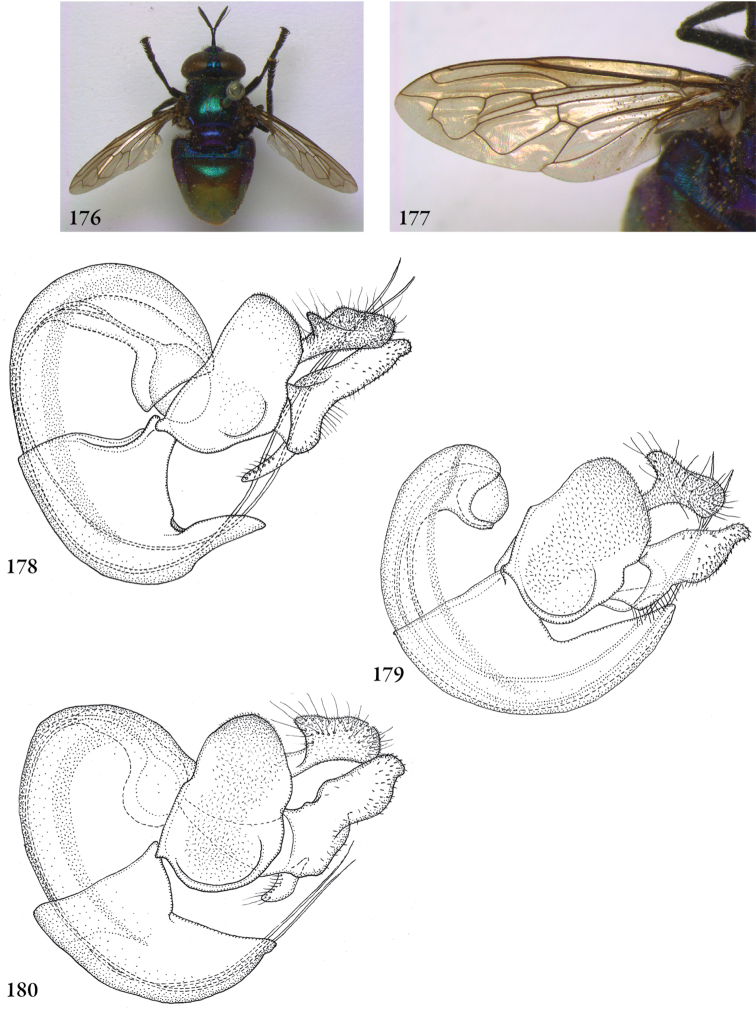
176–178
Microdon (Chymophila) instabilis (holotype): 176 habitus dorsal 177 wing 178 genitalia lateral 179–180
Microdon (Chymophila), male genitalia: 179
Microdon lativentris (holotype) 180 Microdon stramineus (Surinam, coll. RMNH).